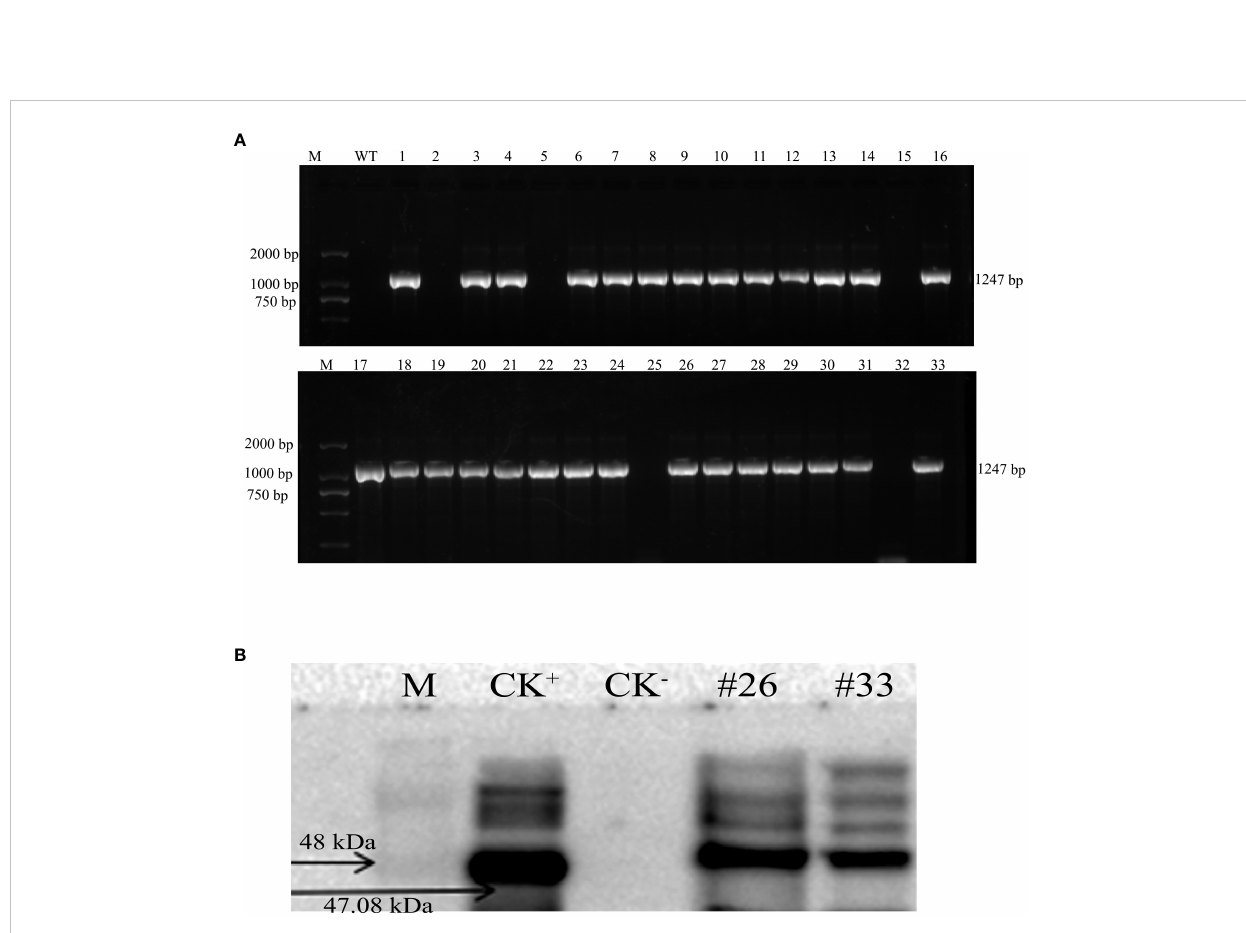
FIGURE 3 Characterization of recombinant MirMAN gene in Arabidopsis. (A) Cloning of MirMAN gene and PCR identi fi cation of T2 transgenic Arabidopsis. (B) The speci fi c antibody was used for Western blotting. (A) M: DL marker 2,000; WT: wild type (negative control); the others are the 33 transgenic lines. (B) M: marker; CK + , positive control; CK − , negative control; the others are the transgenic lines.